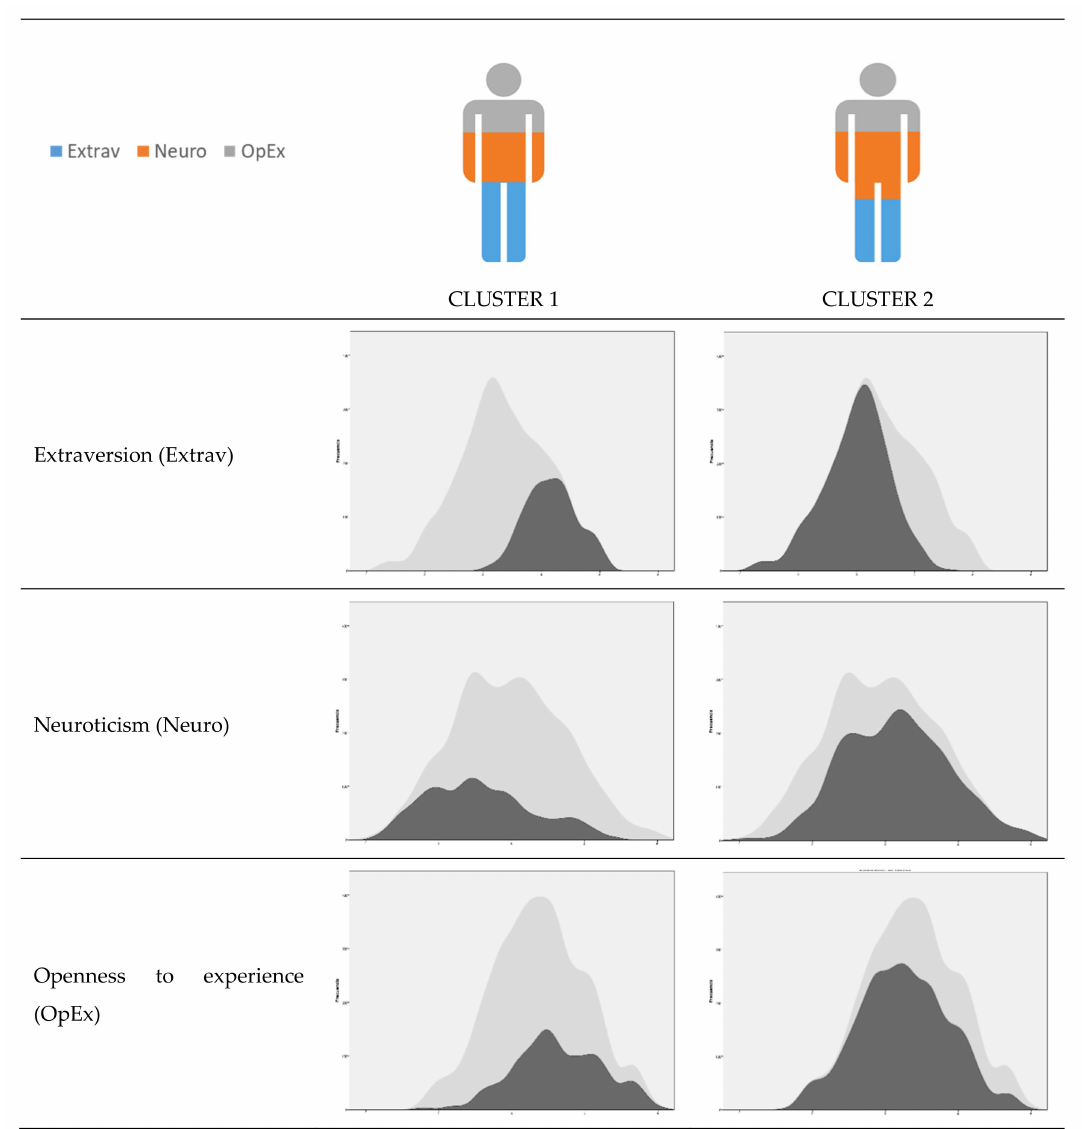
Figure 1. Profile by personality factors related to self-expressive creativity. Note: Factors are presented in order of importance of input. = total sample, = subsamples (c1, c2). The vertical axis in figure indicates